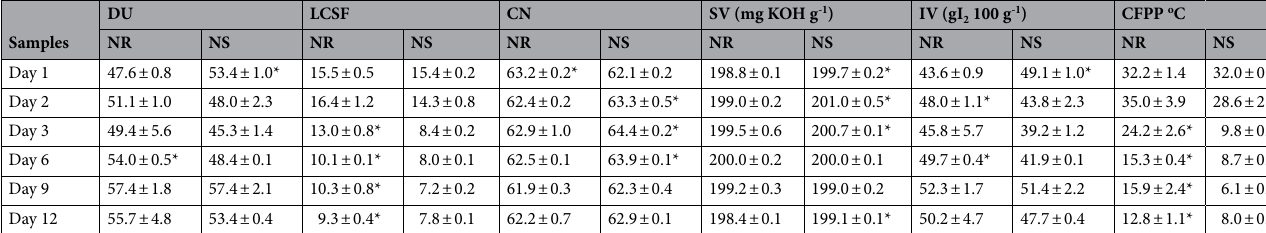
Table 1. Microalgae biodiesel fuel property estimation. Estimation includes three fatty acid classes (SFA, MUFA and PUFA), degree of unsaturation (DU), long chain saturated factor assessment (LCSF), cetane number (CN), saponification value (SV), iodine absorption value (IV) and cold filter plugging point temperature (CFPP). The values are presented as means ± standard deviation (SD) (n = 3). Asterisk (*) represent significant higher using one-way ANOVA ( p < 0.05) with Fisher’s LSD between NS and NR culture